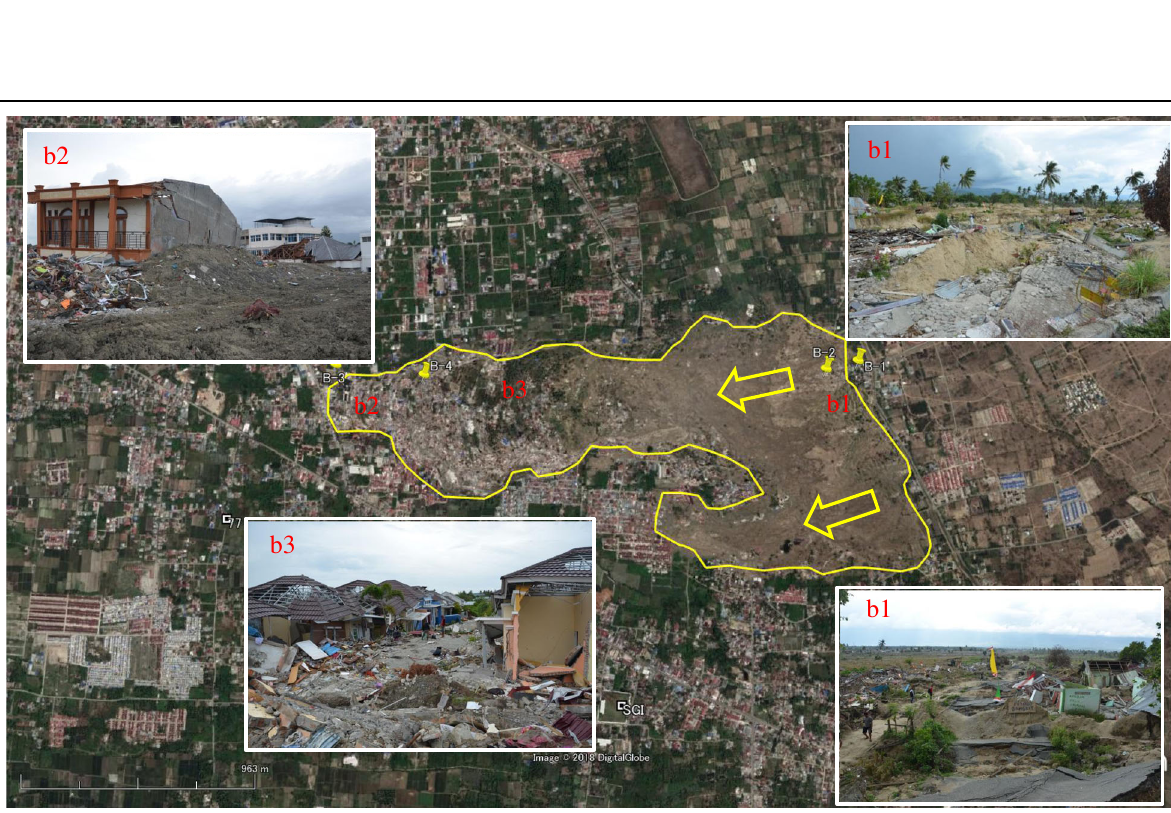
Fig. 10 Satellite photo by Google Earth and some photos of damage in Petobo district in Palu city